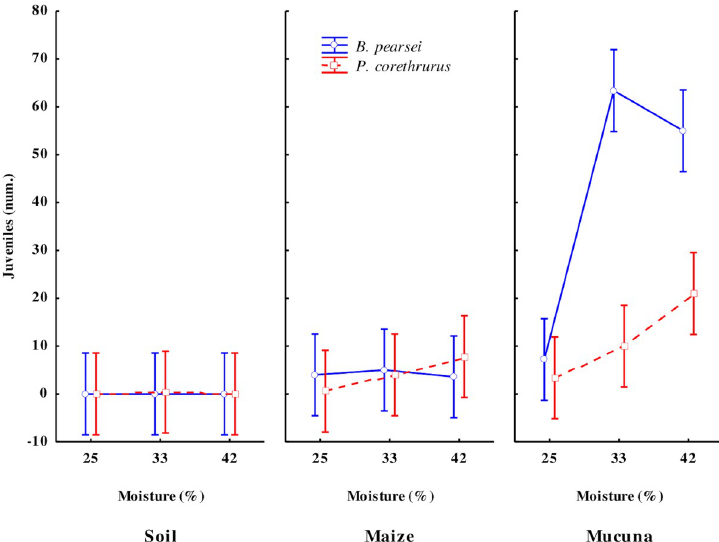
Fig 4. Number of juveniles hatched from cocoons produced by the tropical endogeic earthworms Pontoscolex corethrurus (invasive) and Balanteodrilus pearsei (native) at 100 days of culture under the interaction of three diets of different nutritional quality and three moisture content levels in soil with low anthropic impact. Vertical lines represent standard